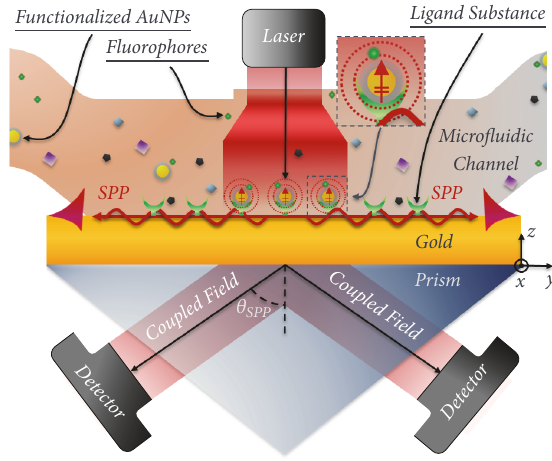
Figure 1: Functional illustration of the SPCE sensor coupled to a microfluidic